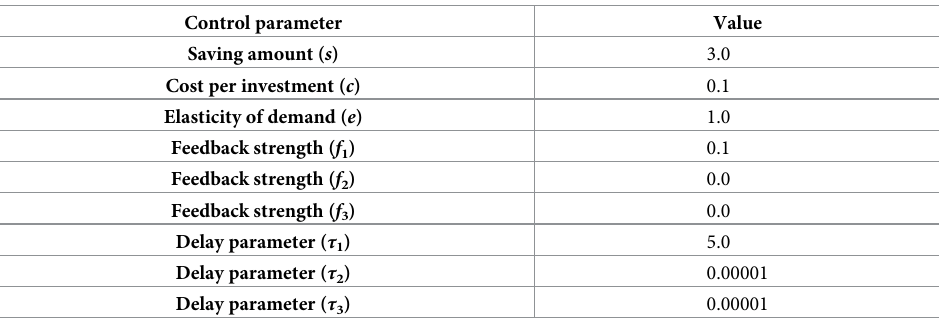
Table 1. Control parameters for financial